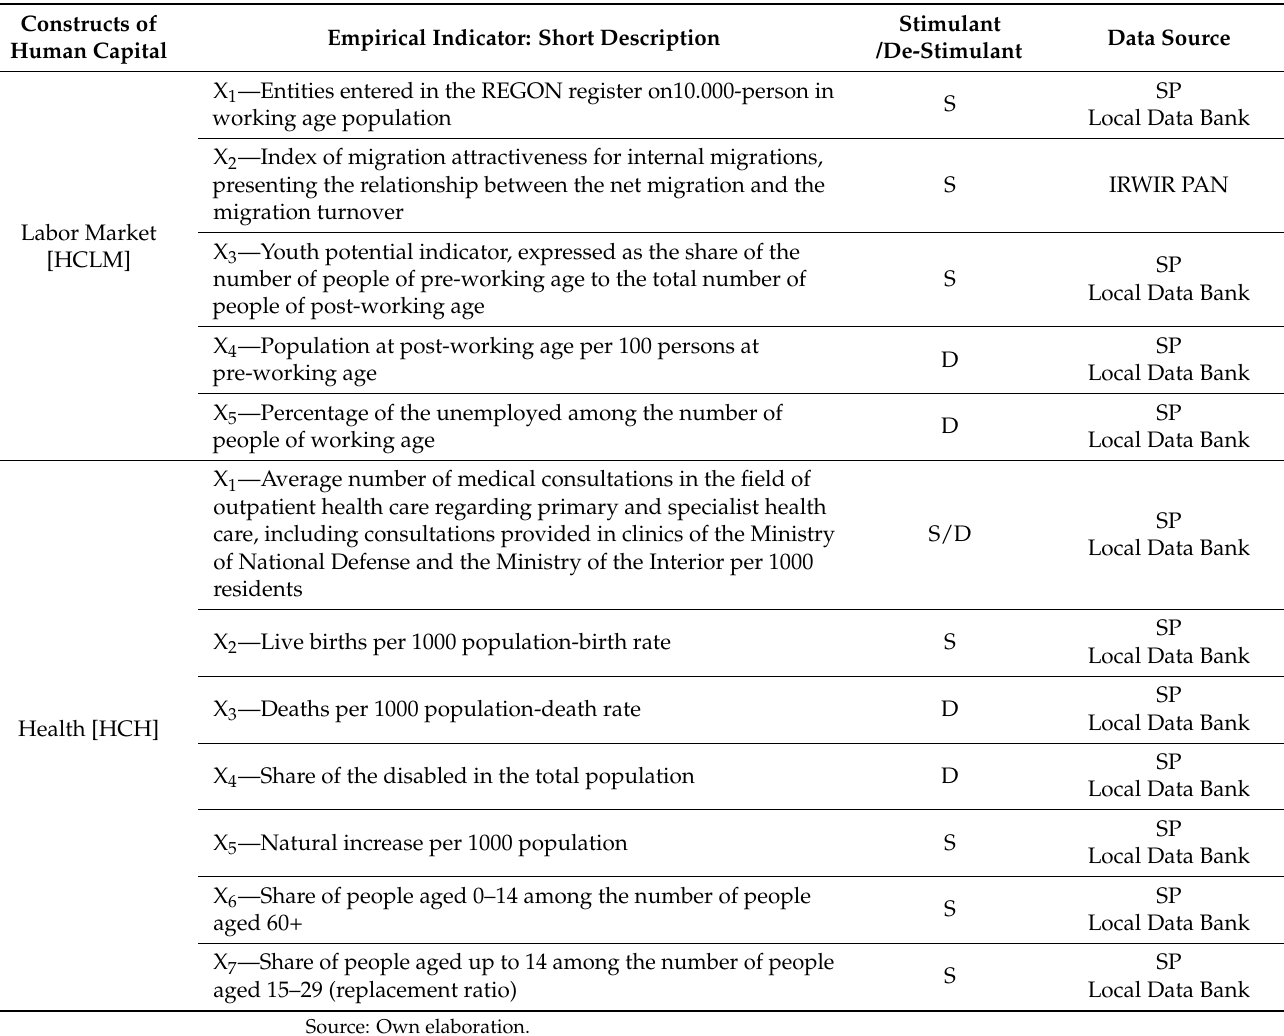
Table 1. Empirical features included in the construction of the synthetic measure of human capital.